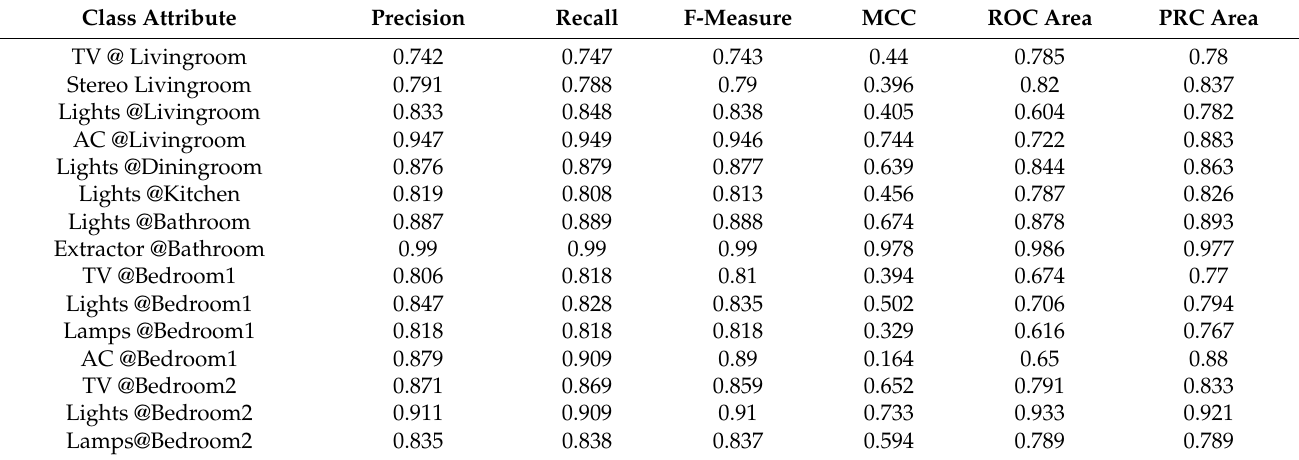
Table 5. C4.5 performance